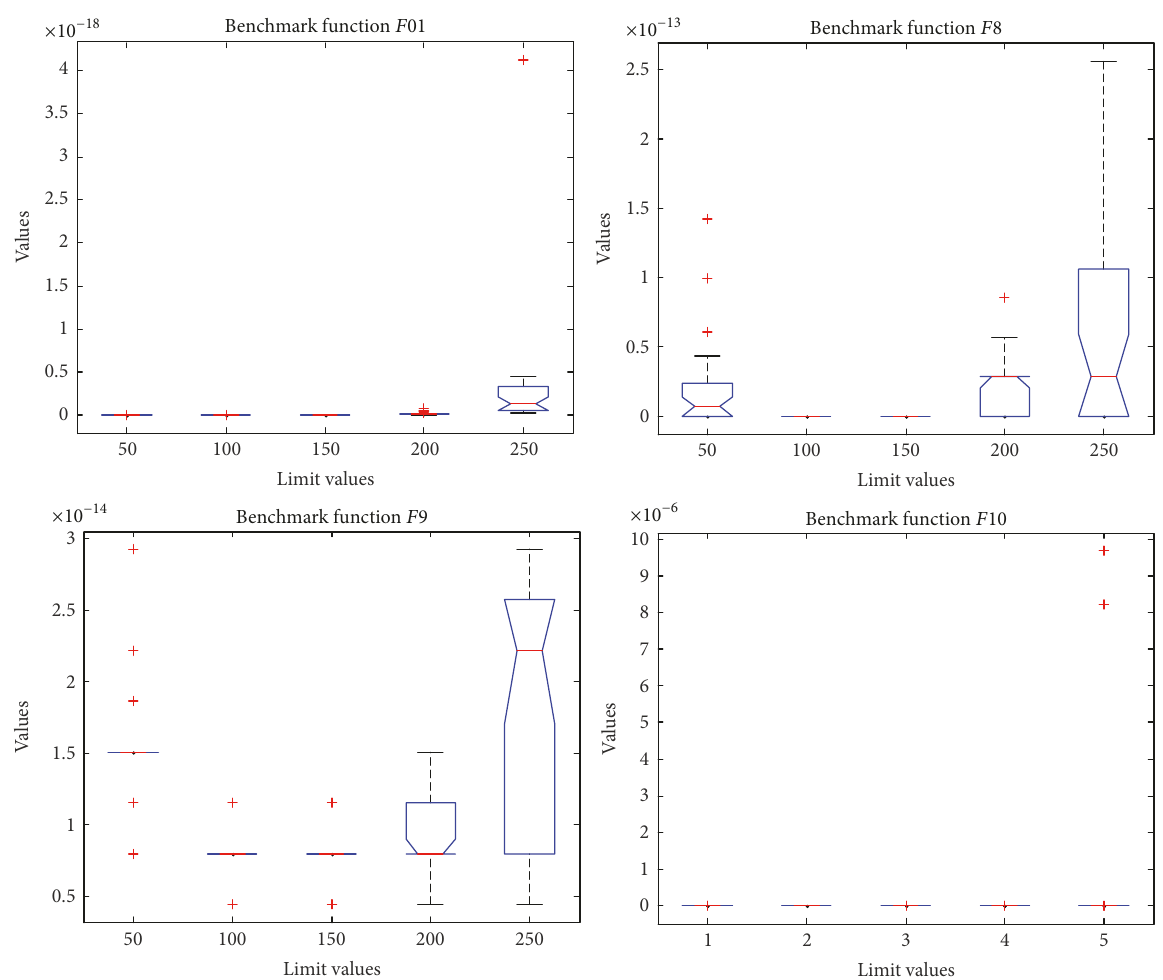
Figure 4: Box plots of different limit values for function f 1 , f 8 , f 9 , and f 10 over 30 independent